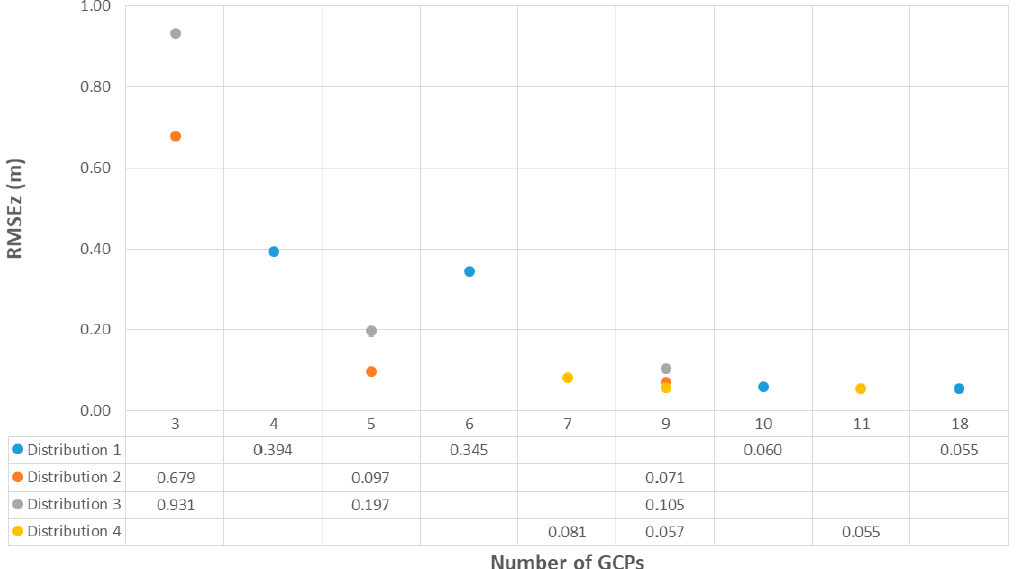
Figure 10. RMSEz values in meters obtained according to the number of GCPs used in the bundle adjustment. Each distribution is represented by a different color.